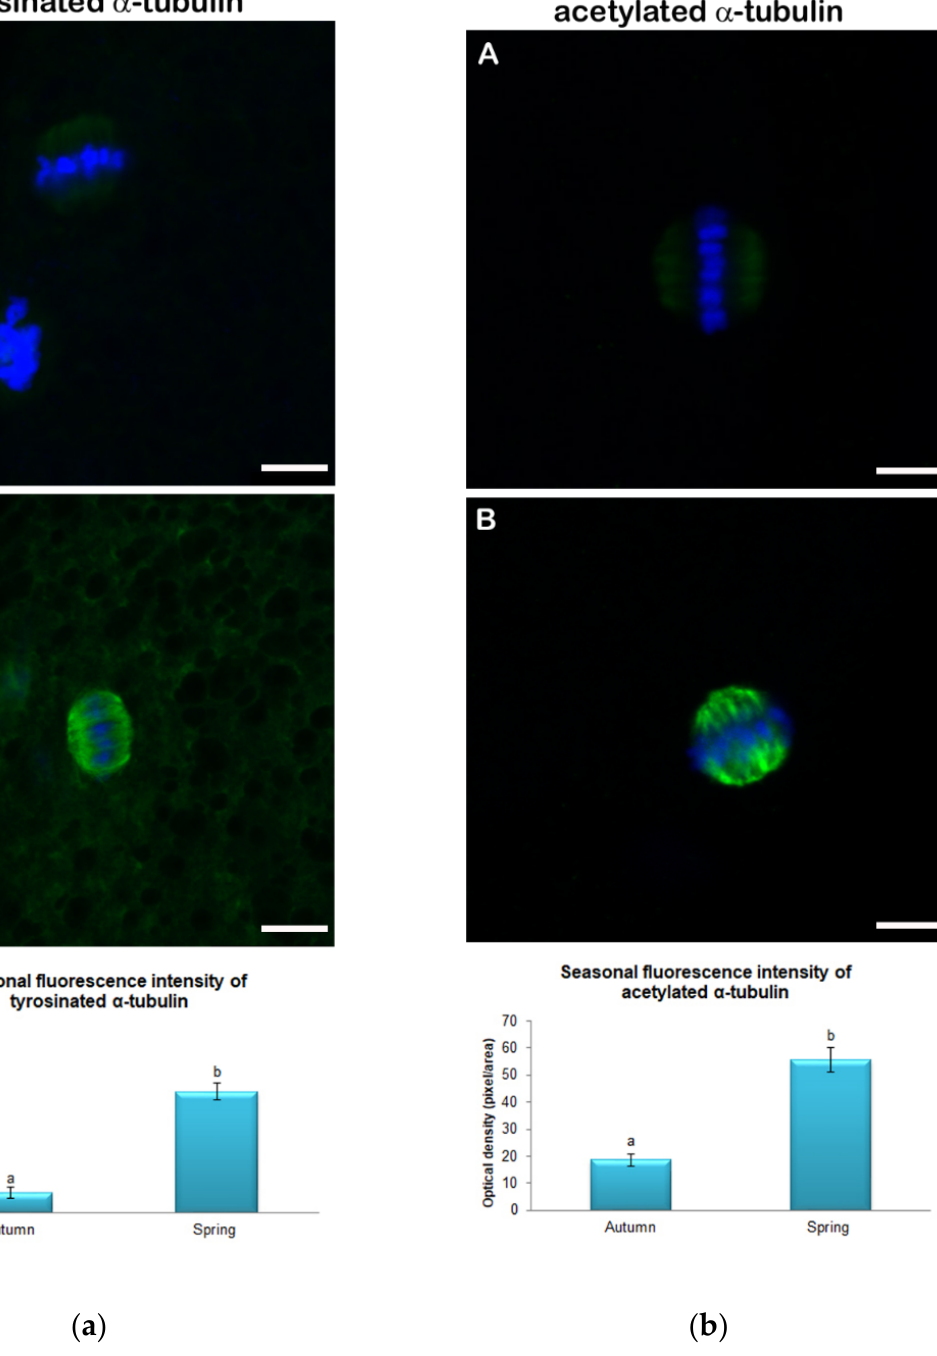
Figure 2. Quantification of fluorescence intensity of tyrosinated ( a ) and acetylated ( b ) α -tubulin in metaphase II prepubertal ovine oocytes collected during Autumn ( A ) and Spring ( B ). Values are expressed as arbitrary units (Mean ± mean standard error). Different lower-case letters indicate statistical difference in tyrosinated α -tubulin fluorescence intensity in autumn and spring ( p < 0.01 ANOVA).